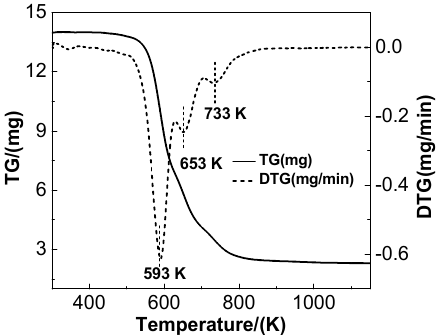
Processes 2019 , 7 , x FOR PEER REVIEW Figure 1. Pyrolysis of polyurethane foam measured at the heating rate of 5 K·min − 1 in N 2 atmosphere. Figure 1. Pyrolysis of polyurethane foam measured at the heating rate of 5 K · min − 1 in N